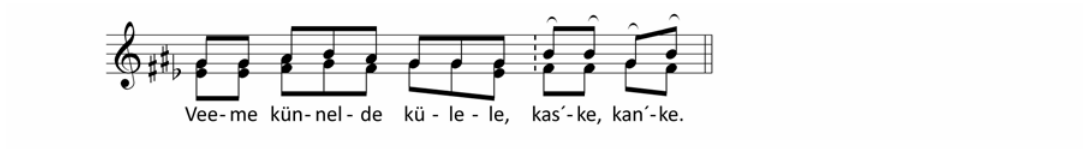
Figure 2: 8-position verses where the last stress of a polysyllabic word is in the even verse position, two last stress groups have three positions (2+3+3 structure). The choir of Elena Laanetu, ’We’ll take [him] to the candles’.